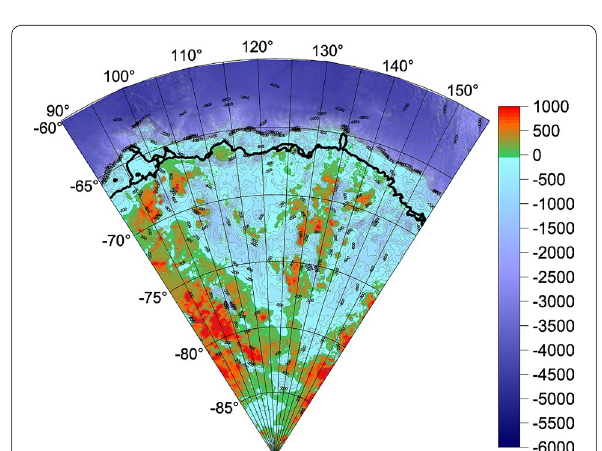
Fig. 3 Bedrock topography (Bedmap 2) in the Wilkes Land area, absolute sea level [m]. Blue color indicates the height below the present-day sea level